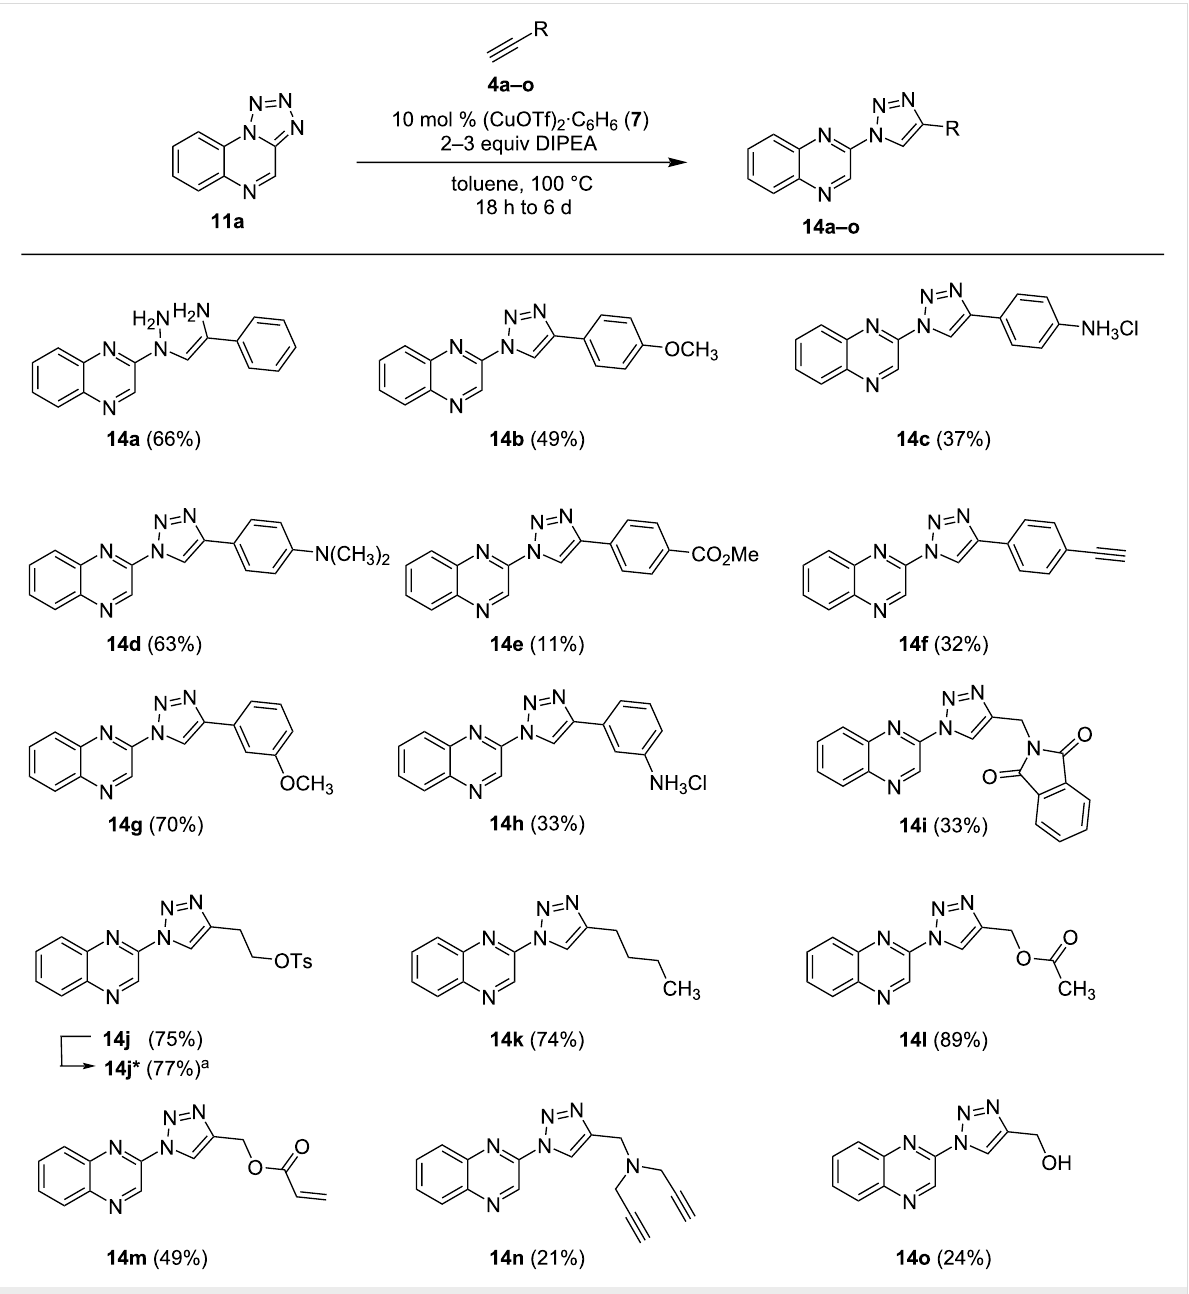
Scheme 3: Synthesis of 1,2,3-triazole-substituted quinoxalines via CuAAC from tetrazolo[1,5- a ]quinoxaline ( 11a ). a Synthesis of 14j* from 14j =